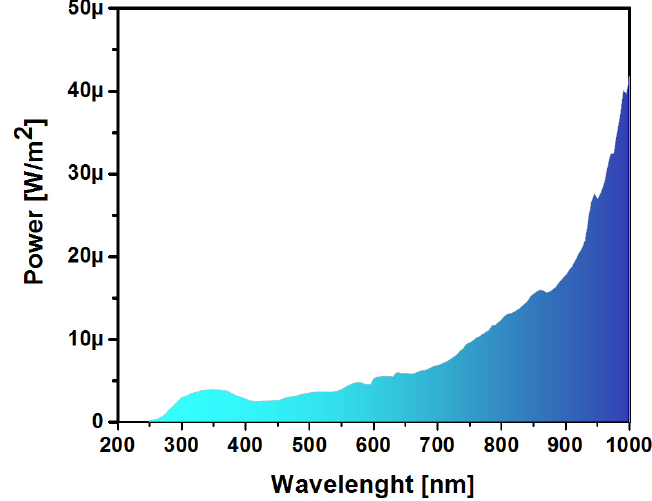
Figure 16. Light power pattern of the monochromator used as a function of the wavelength.